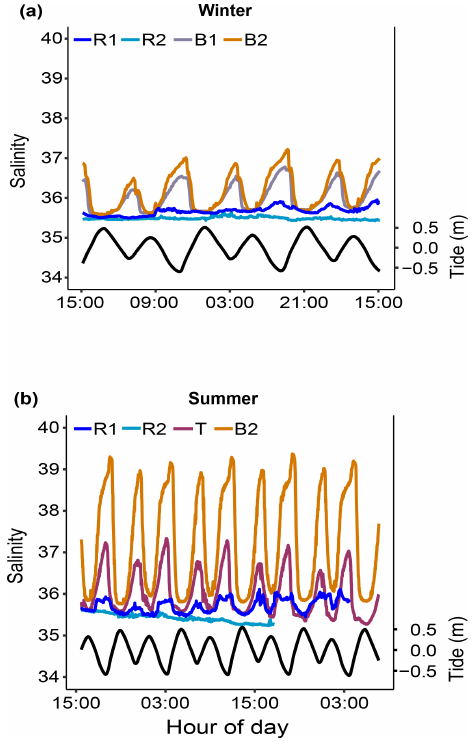
Figure 7. Short-term salinity monitoring during (a) the winter of 2019 (from 15 to 18 July 2019) at the reference (Sts R1 and R2) and Bouraké (Sts B1 and B2) reefs and (b) the summer of 2020 (from 29 November to 4 December 2020) at the reference (Sts R1 and R2) and Bouraké (Sts T and B2) reefs. Tide (black line) refers to St B2.